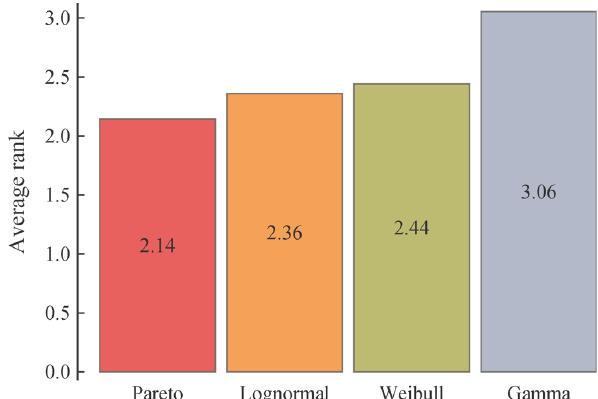
Fig. 6. Histograms of the shape parameters of the fitted